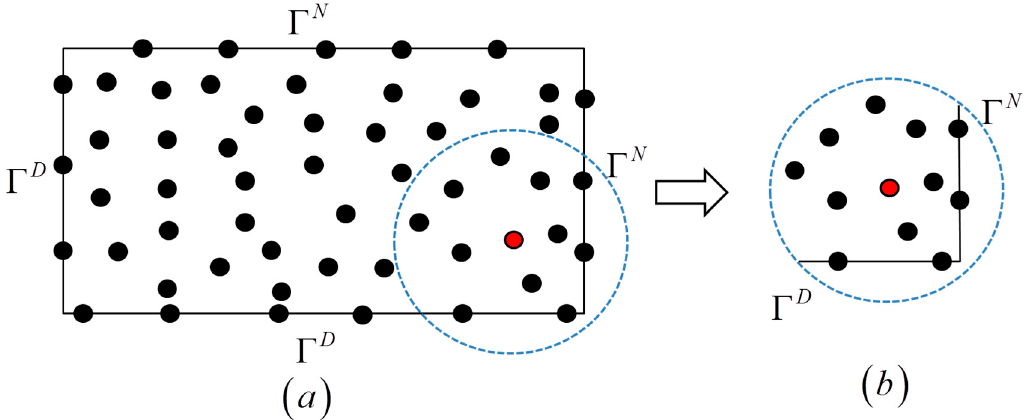
Figure 1. Schematic diagram for the computational domain. ( a ) Boundary and distribution of nodes and ( b ) subdomain.